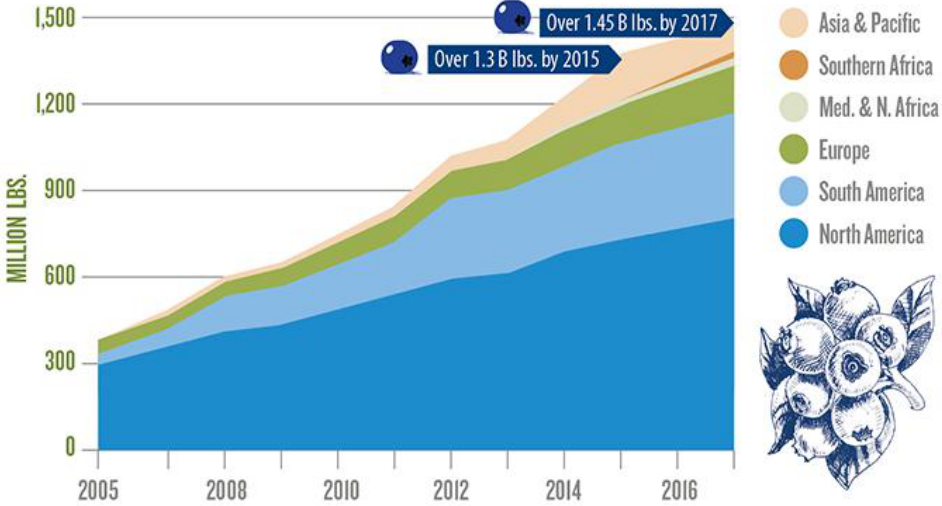
Figure 1. World highbush blueberry production: Growth predictions (source: Cort Brazelton—North American Blueberry Council 2014. Reproduced with permission from North American Blueberry Council).